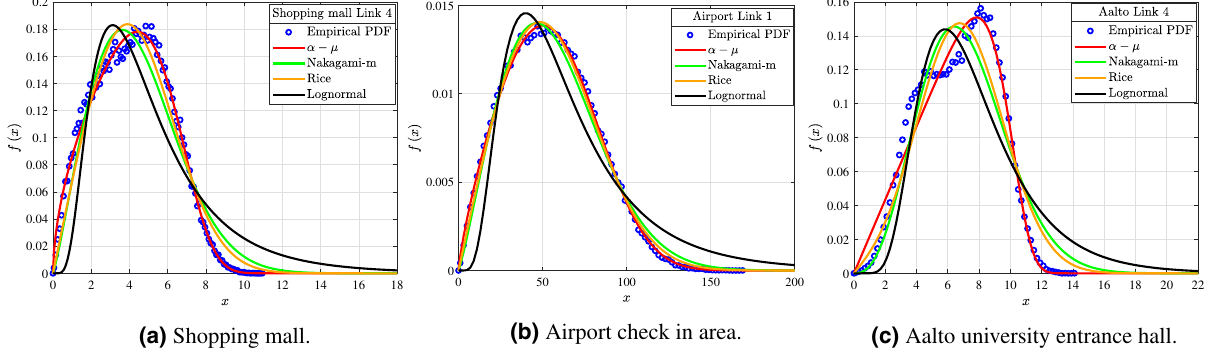
Figure 2. Fitting of α – µ , Rice, Nakagami-m and Lognormal PDF to the empirical ones.